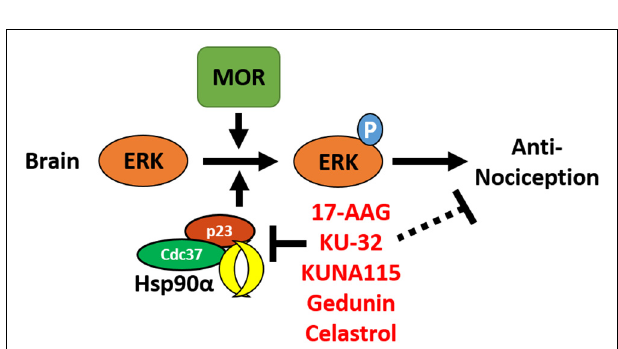
FIGURE 6 | Model for the regulation of mu opioid receptor (MOR) signaling by Hsp90 in the brain. This summary model combines results from this manuscript with our earlier work using non-selective Hsp90 inhibitors in the brain (Lei et al., 2017). Together this data suggests that Hsp90 α , p23, and Cdc37 act in concert in the brain to promote the phosphorylation of ERK MAPK by the MOR in response to opioid drugs, thus promoting opioid anti-nociception. Treatment with non-selective or selective inhibitors blocks this role, thus blocking ERK MAPK phosphorylation and blocking anti-nociception in response to